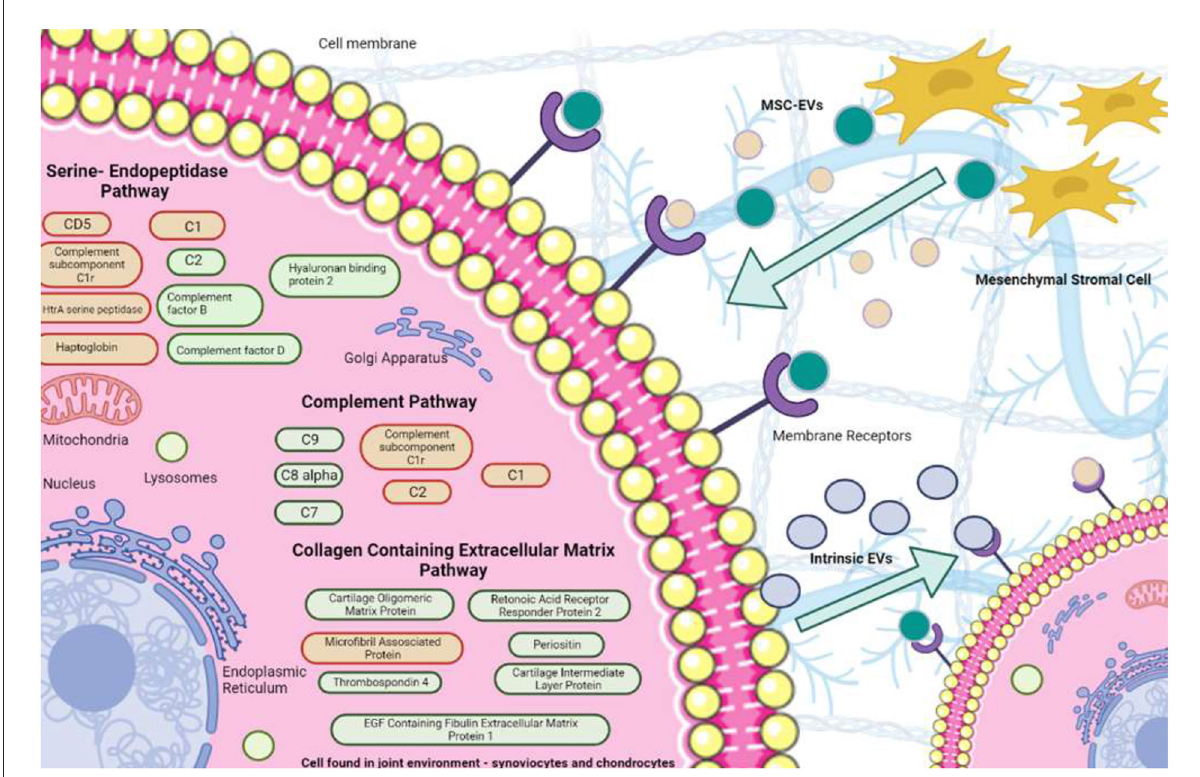
FIGURE8 Potential mechanisms of action of SF-EVs following MSC treatment. EVs were sourced from both MSCs and the intraarticular environment. We hypothesized that MSC-EVs affect the intraarticular cells through their differential protein cargo, resulting in altered EV secretion from intrinsic cells. DE proteins attributed to given pathways are red (decreased expression to meet baseline or surpass it by day 70) or green (increased expression to reach baseline at day 70).